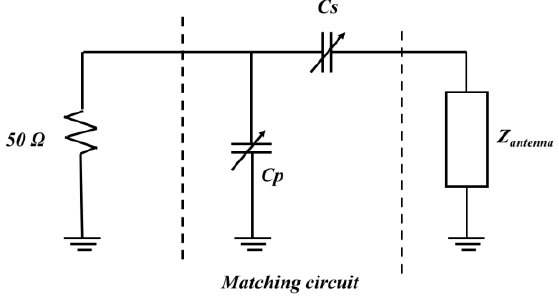
Figure 3. Gamma-matching circuit.